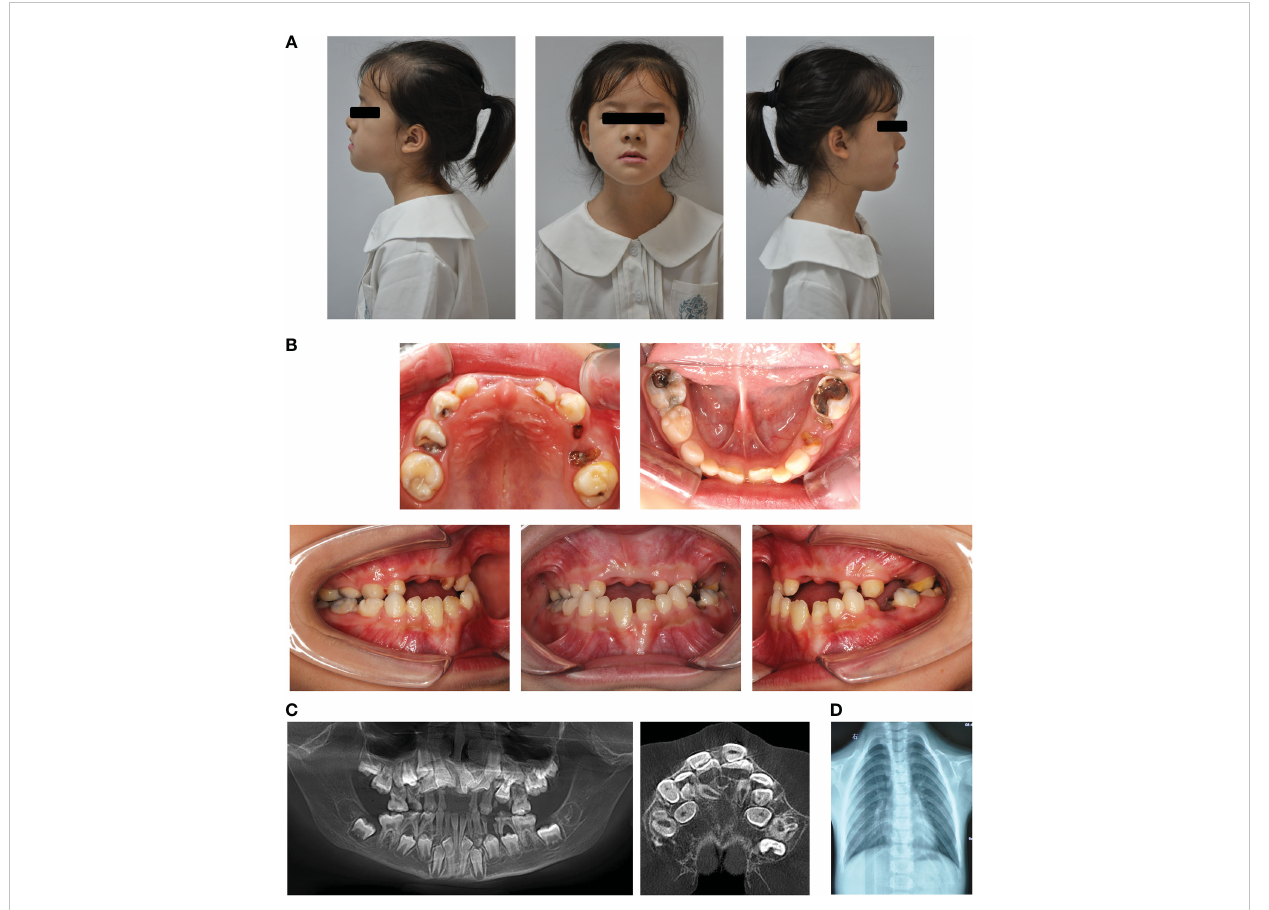
FIGURE 1 Typical clinical and radiological fi ndings in the proband with CCD. (A) Front and pro fi le photographs of the individual showing a concave face, hypoplasia of the maxilla, and a depressed nasal bridge. (B) Intraoral images showing enamel and dentin hypoplasia. (C) Panoramic view showing embedded permanent, supernumerary, and retention of deciduous teeth. (D) Chest radiograph showing hypoplasia of the left